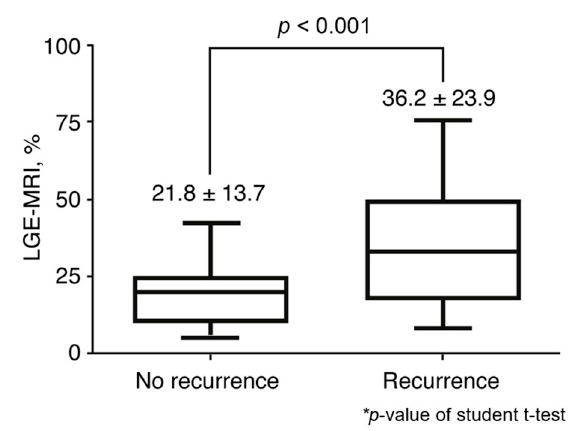
Figure 3. Comparison of MR LGE burdens between patients with and those without clinical recurrence after catheter ablation.